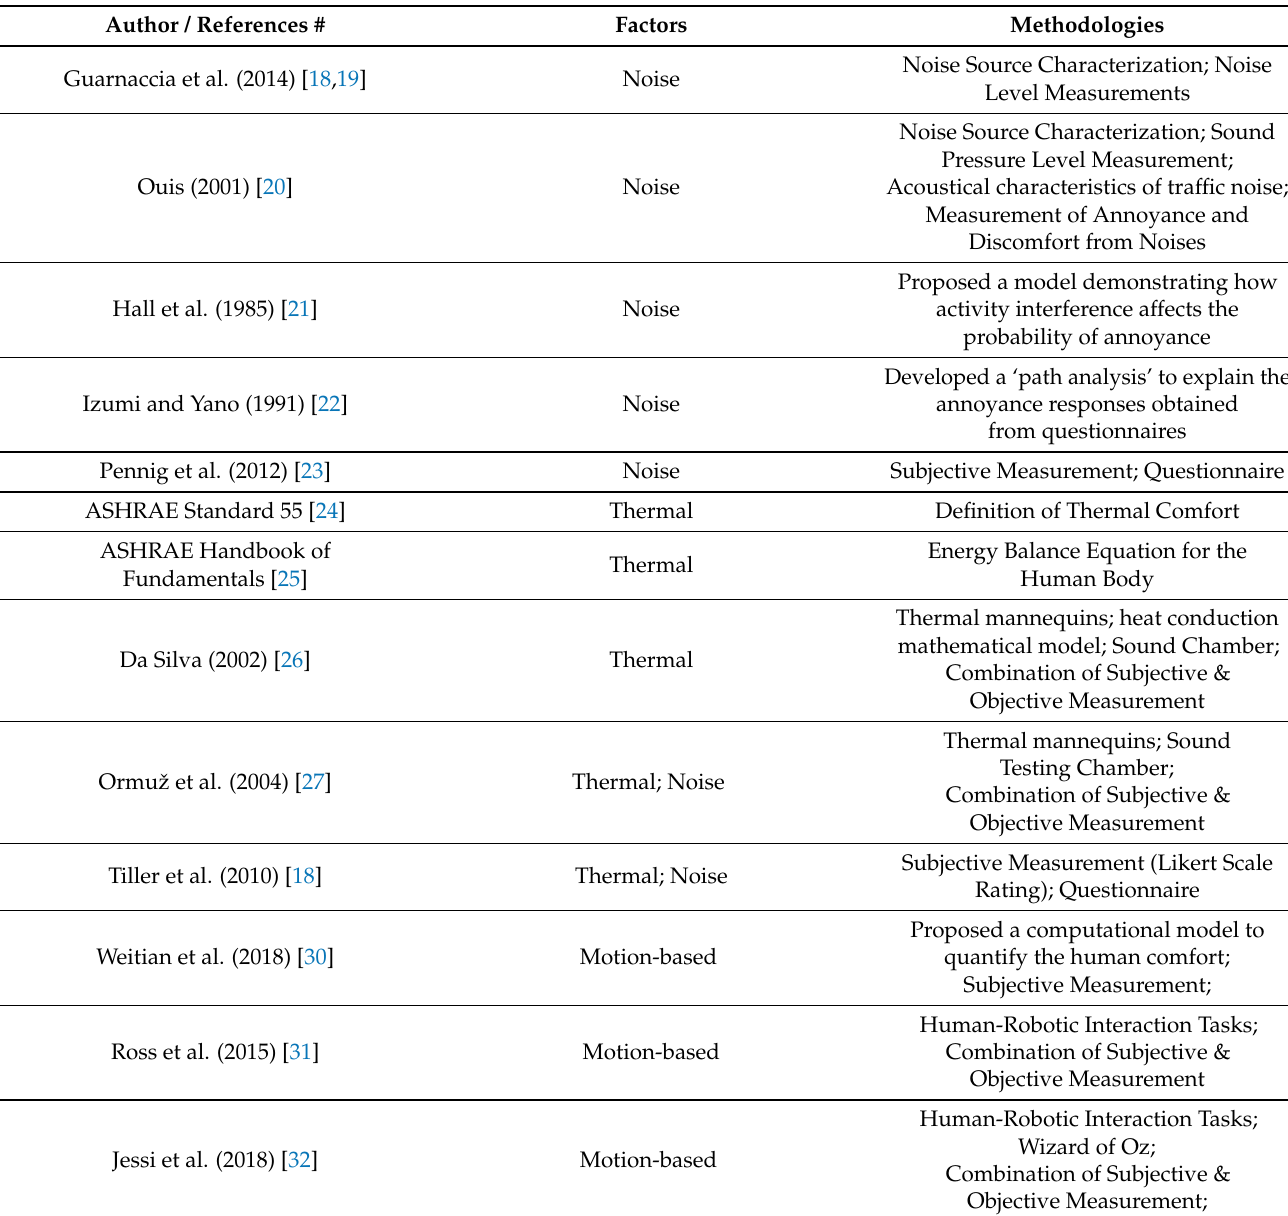
Table 1. Influential factors of human